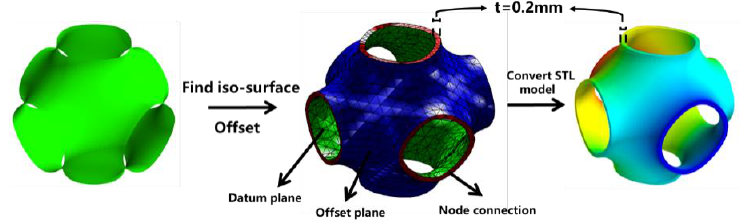
Figure 1. Schematic of P-TPMS structure.